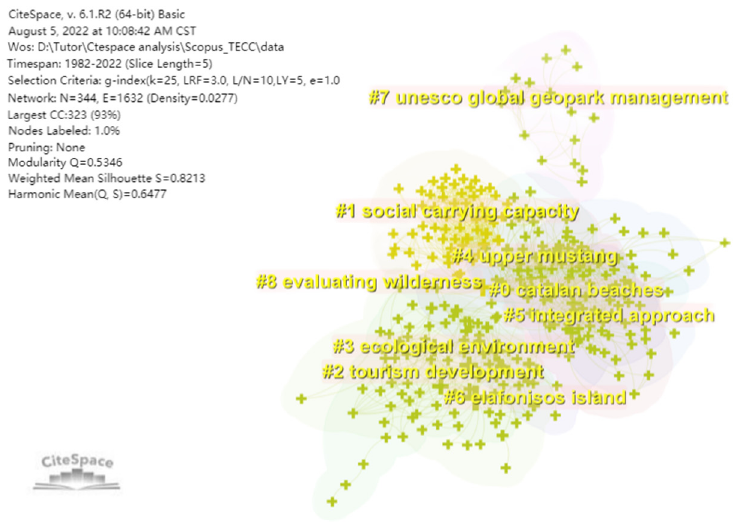
Figure 4. Keyword co-occurrence analysis with 5 years as a time slice.